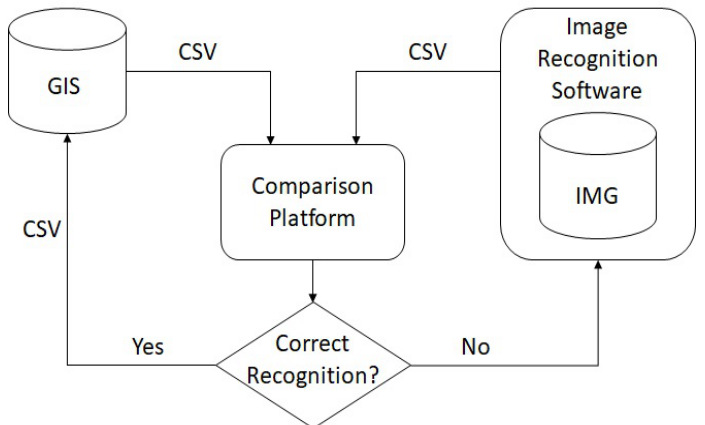
Figure 5. Image validation process.